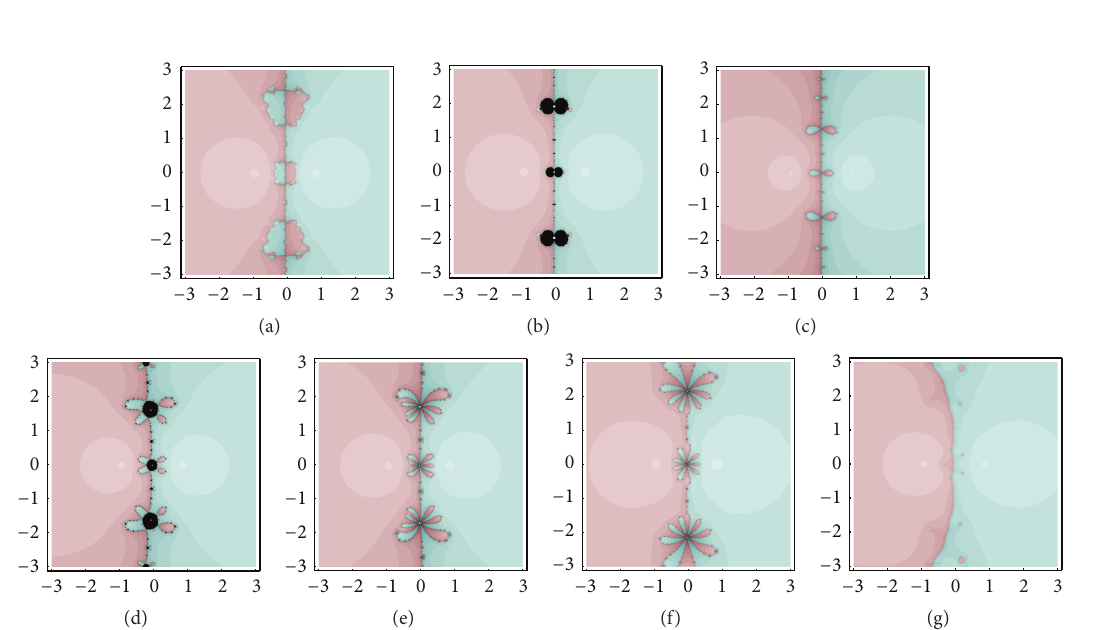
Figure 1: (a) for Kan , (b) for Sol , and (c) for Zhou and (d) for 1D , (e) for 1G , (f) for 2D , and (g) for 2G , for the roots of the polynomial (𝑧) = (9𝑧 2 + 𝑧 − 7) 2 𝑃 1